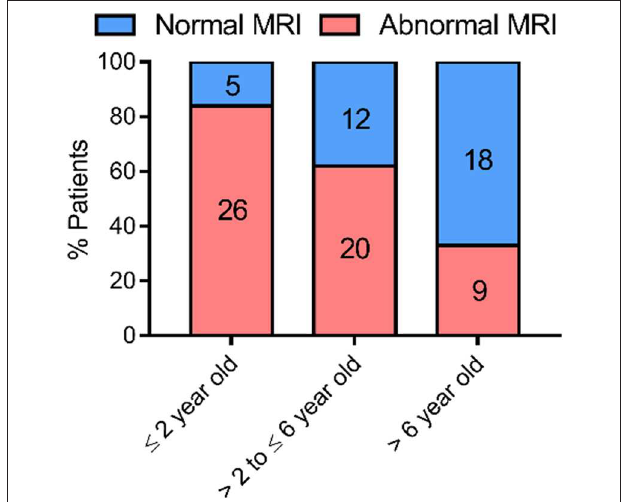
FIGURE 1 | Evolution of myelination based on MRI data obtained from case-reports of 90 AHDS patients. The WM status as observed in the last MRI of each patient was used for the analysis. Sequential MRIs were not taken up in the analysis, so that each data point represents one patient. We ascribed a patient to the group “normal MRI” whenever the report specifically mentioned a normal WM status or the complete absence or disappearance of WM abnormalities in the last exam. In case a delay of any degree was reported or WM status showed abnormalities, we ascribed the patient to the group “abnormal MRI.” The references for the patient reports used for this analysis can be found in Table 1 . This graph was made using GraphPad Prism v7.00.